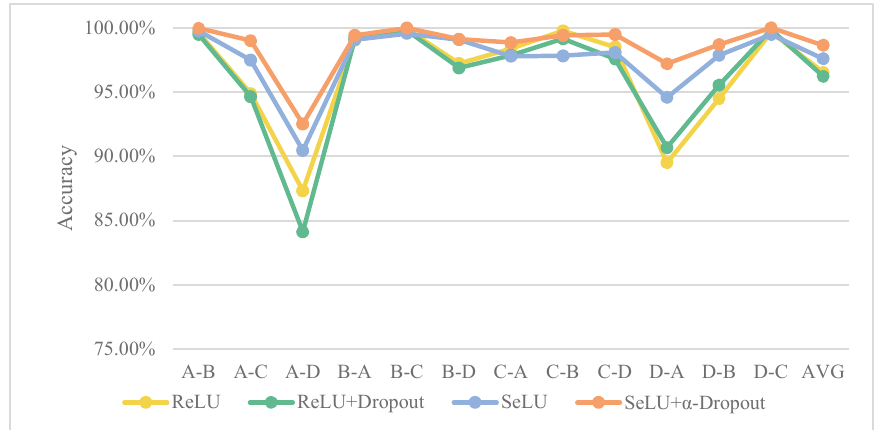
Figure 12. Effects of SeLU and α -dropout on the generalization capability of